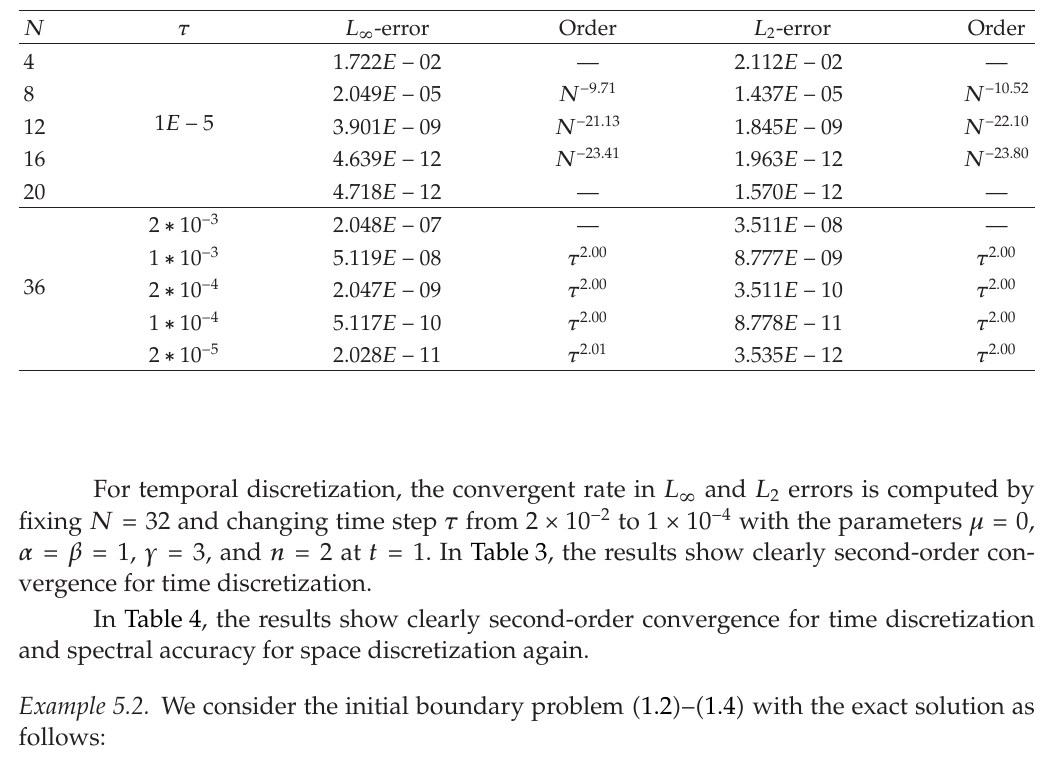
Table 5: Convergence rates at t (cid:7) 1 with μ (cid:7) 0 . 1, α (cid:7) 1, β (cid:7) 0 . 01, γ (cid:7) 3, and n (cid:7)